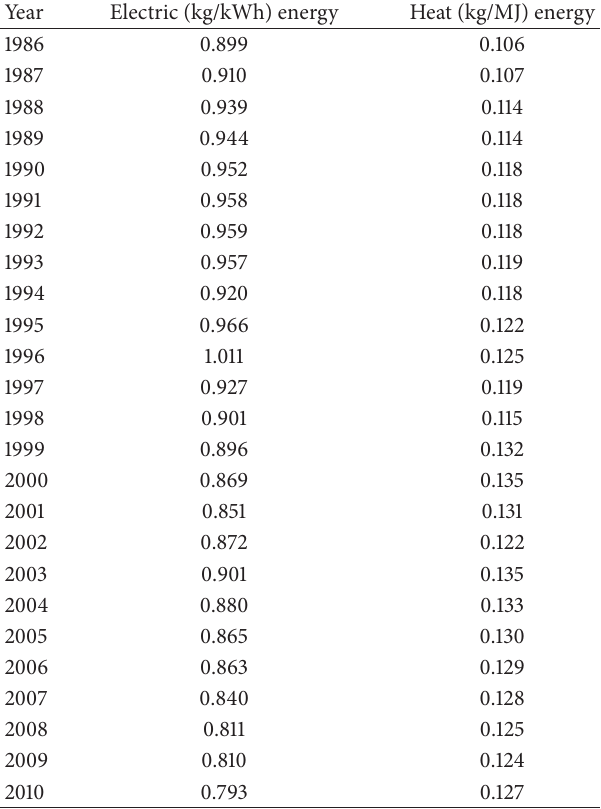
Table 4: CO emissions of per unit power and 2